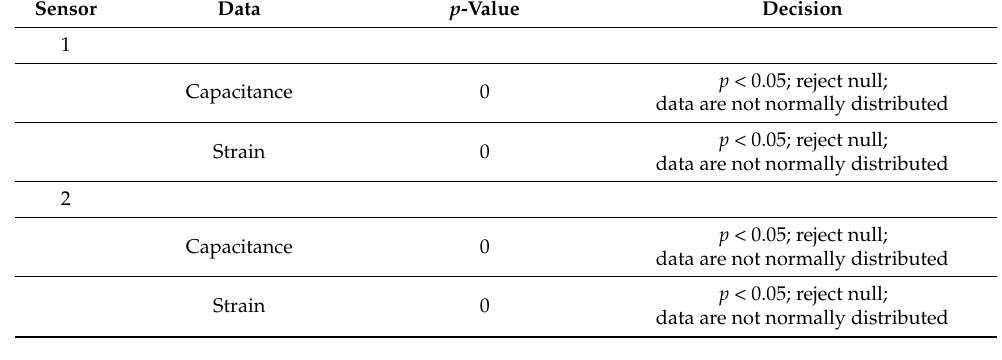
Table 2. Results of the Lilliefors Test of Normality for the Fatigue Test Data.